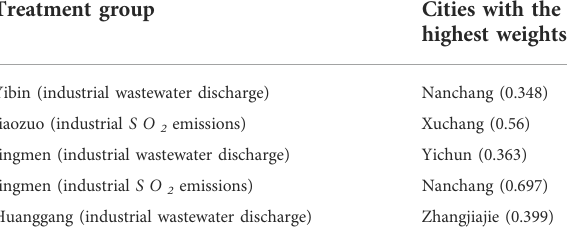
TABLE 4 Cities with the highest weights in the synthetic treatment group and their weights. Treatment group Cities with the